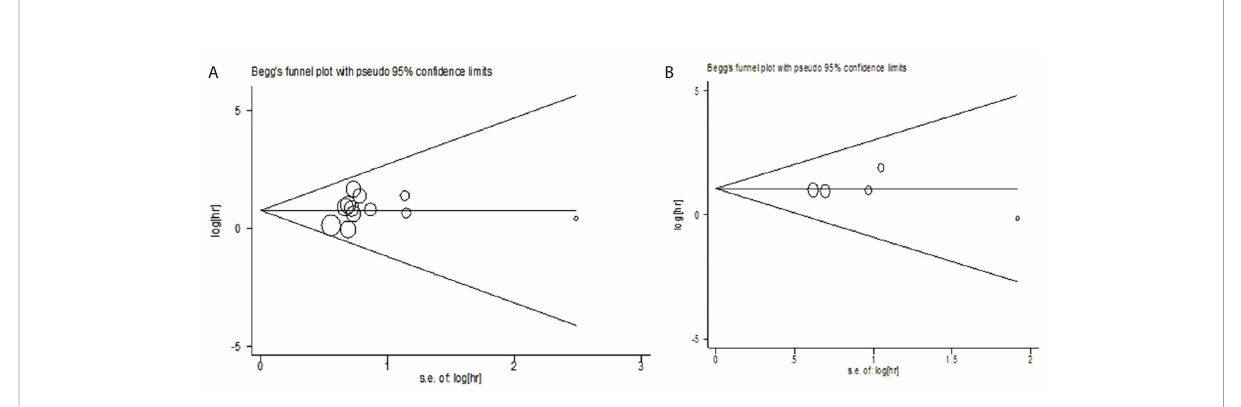
FIGURE 5 (A) The relationship between CTC and OS. (B) The relationship between CTC and